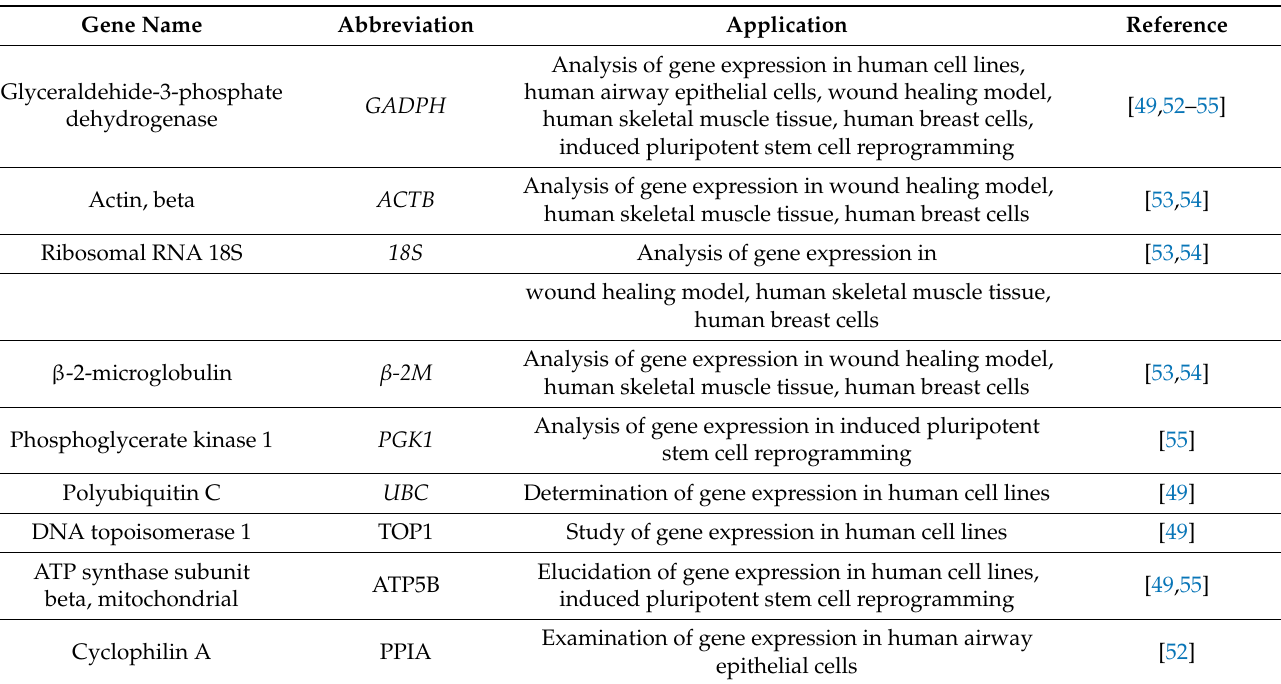
Table 2. Examples of some reference genes commonly applied for analysis of gene